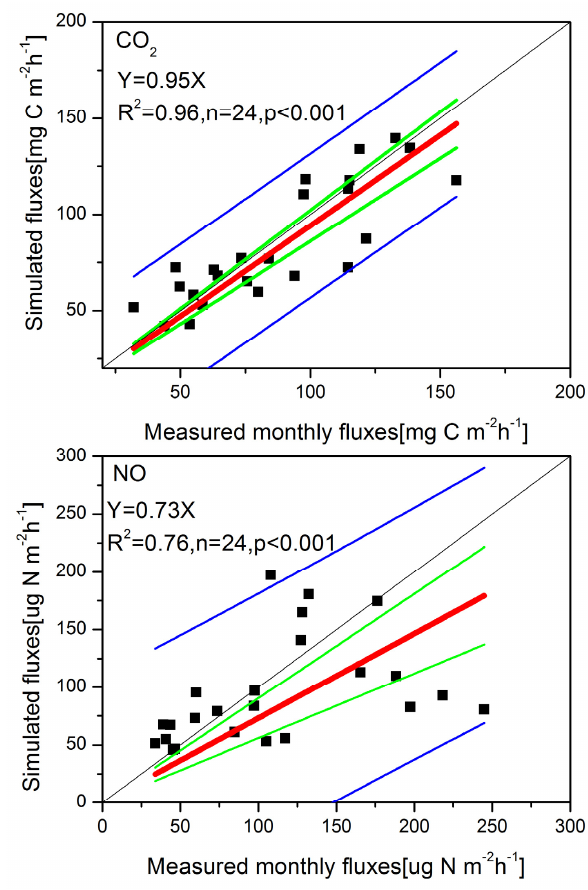
Fig. 9. Monthly mean measured versus monthly simulated soil CO 2 and NO fluxes using the best empirical relationship as presented in Table 5. The red line shows the linear regression of simulated monthly vs. measured monthly flux. Note that the green and blue lines represent the 95% confidence limits for slope and expected data point distribution, respectively.